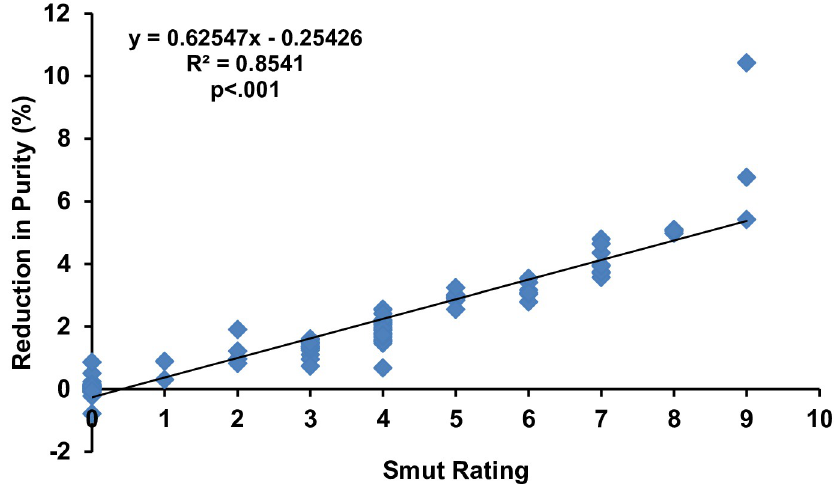
Fig 4. Regression analysis of purity percentage with whip smut disease rating. Note: The smut rating is not a linear scale. It’s based on the transformation explained in methods from linear incidence value to the rating. Accordingly, the resulting disease incidences were converted into 0–9 disease rating scale [41], where 0: no disease, 1: 0.1–2.5%, 2: 2.6– 5.5%, 3: 5.6–7.5%, 4: 7.6–12.5%, 5: 12.6–15.5%, 6: 15.6–18.0%, 7: 18.1–22.5%, 8: 22.6–25.5% and 9: 25.6–100%.